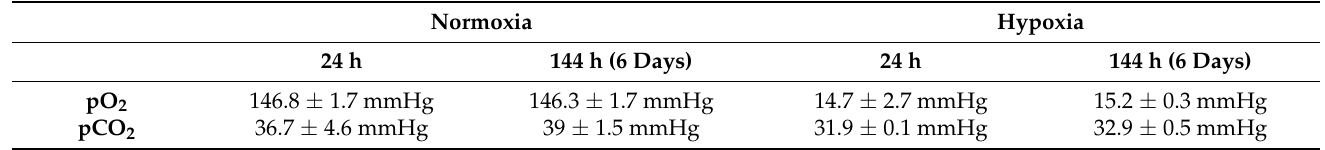
Table 1. The values of oxygen pressure and carbon dioxide pressure in the culture media incubated for 24 h and 144 h (6 days) under normoxic and hypoxic